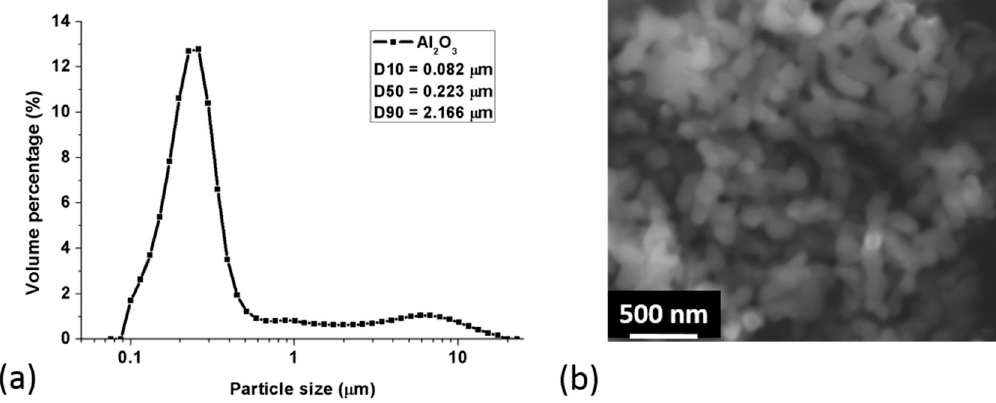
Figure 2. ( a ) Particle size distribution and ( b ) scanning electron microscopy (SEM) morphology of the raw Al 2 O 3 powders.